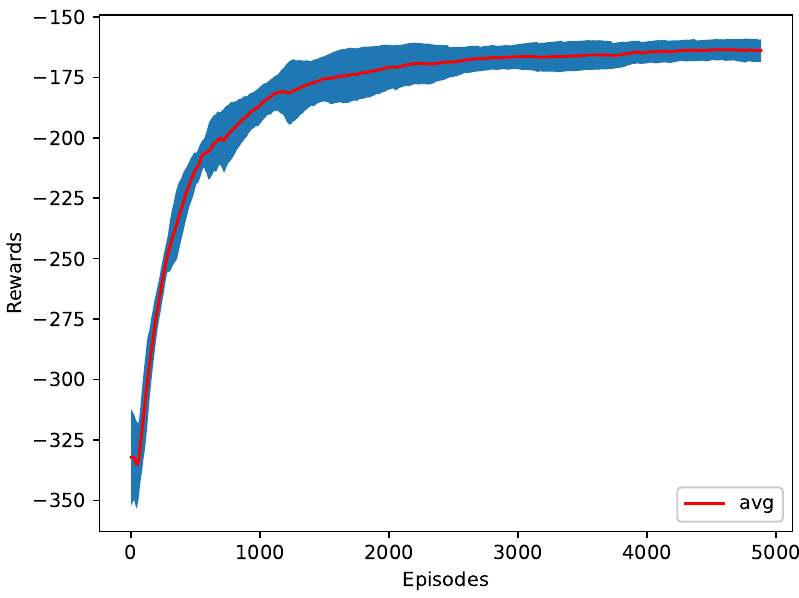
Figure 12. The training plot of the average jerk as a reward